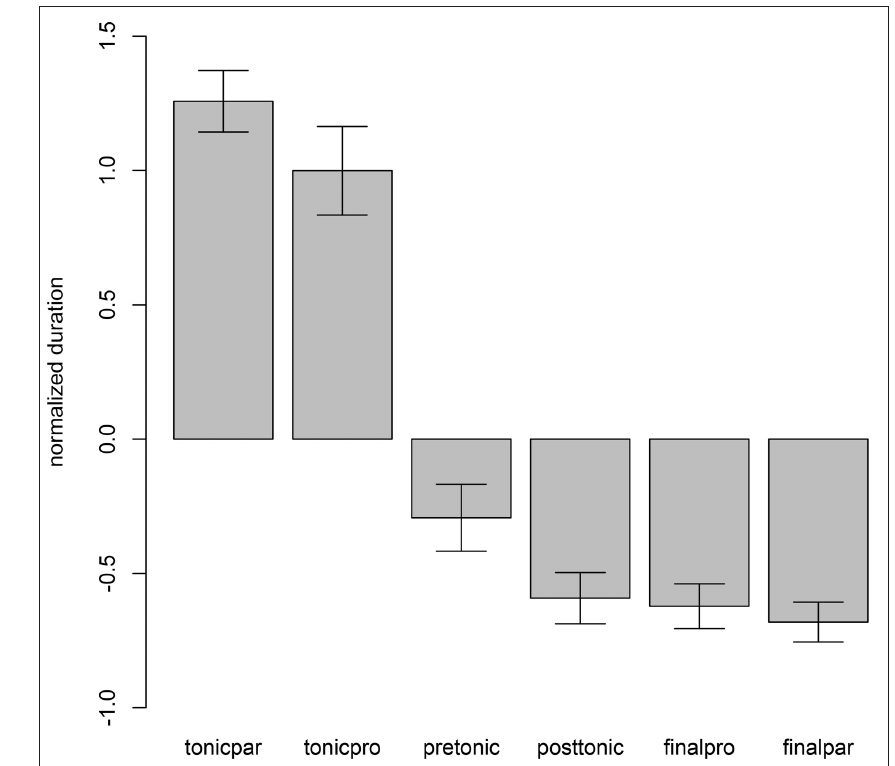
Figure 1: Normalized duration of vowels in six syllable positions from set A. Error bars are 95% confidence